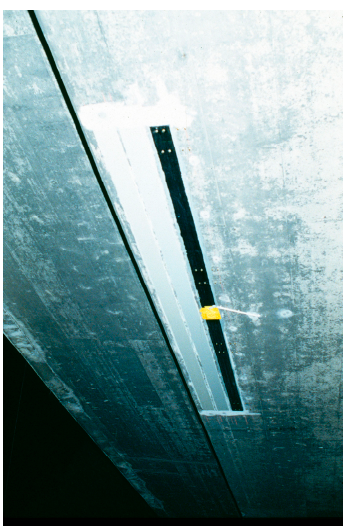
Figure 7. Applied CFRP strips on the Ibach bridge in the year 1991 (two strips were painted for